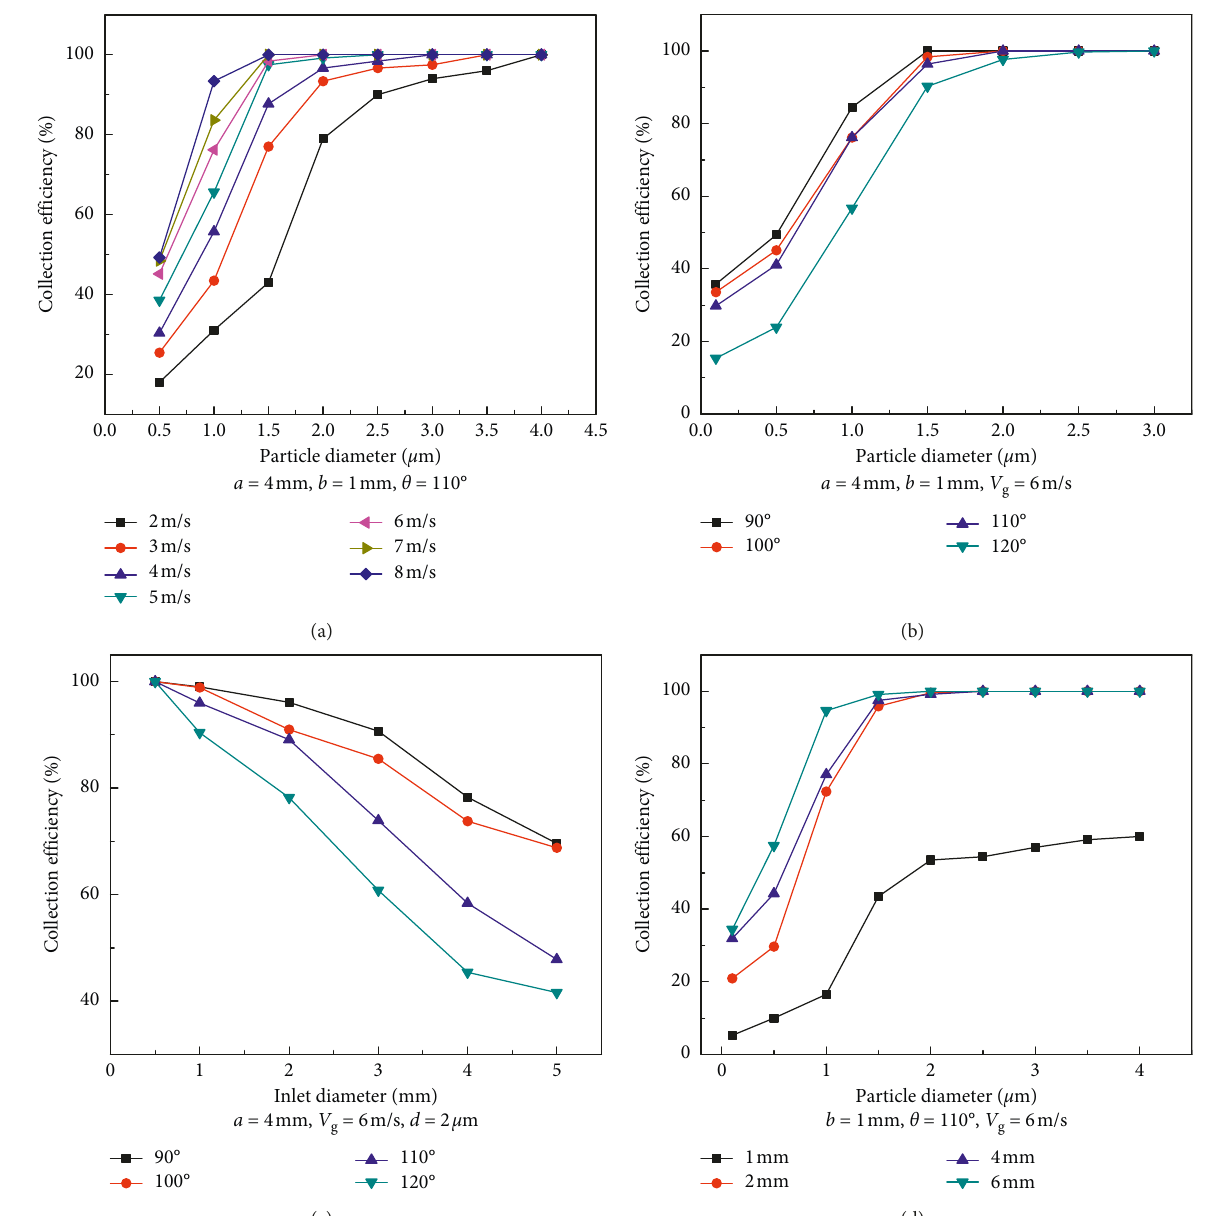
Figure 6: (a) The influence of inlet airflow velocity on collection efficiency; (b) the influence of turning angle on collection efficiency; (c) the influence of inlet diameter on collection efficiency; (d) the influence of pipe length on collection